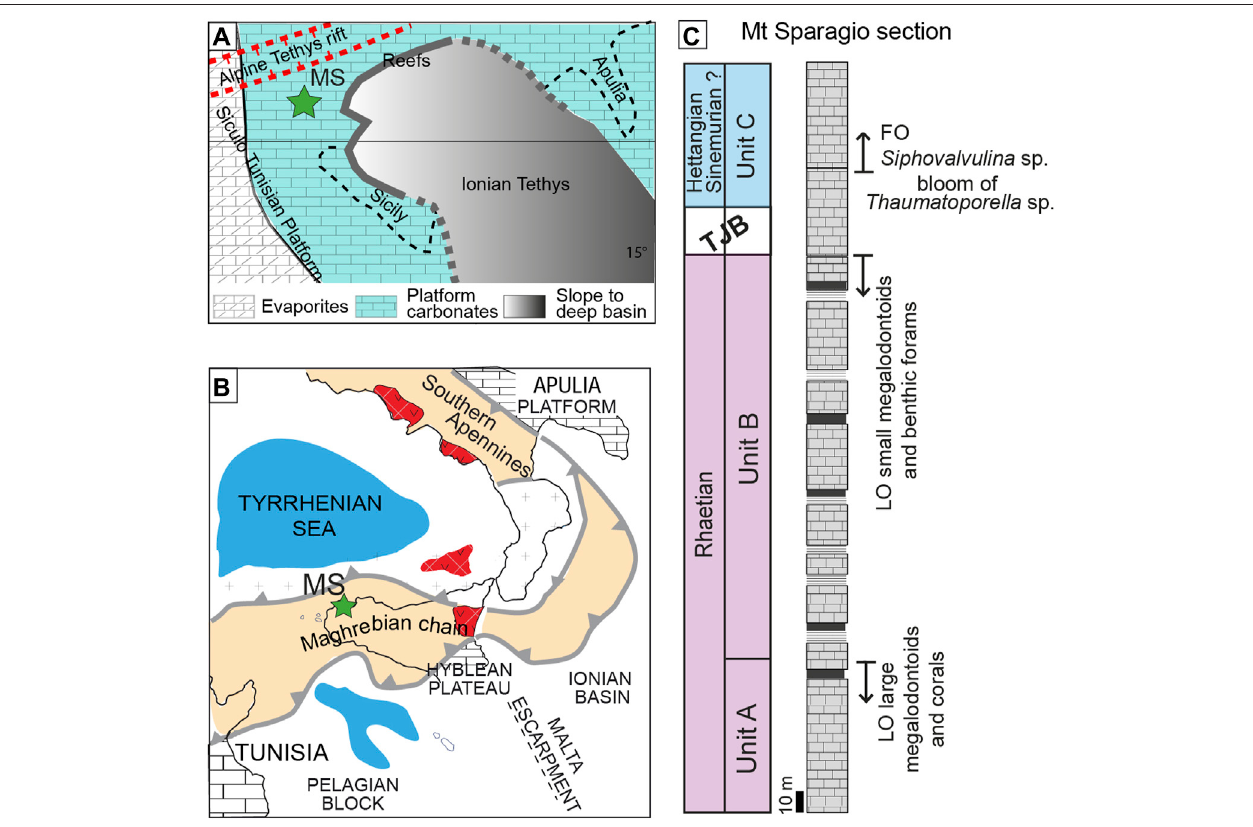
FIGURE 1 | (A) Paleogeography of the central Mediterranean area during the Late Triassic (modi fi ed after Di Stefano et al., 2015; paleolatitude after Muttoni et al., 2015). (B) SchematicstructuralmapoftheCentralMediterraneanarea. (C) ThethreeinformalunitsdescribedintheMtSparagiosectiondifferentiatedonthebasisofthe fossil associations in the subtidal facies (Modi fi ed after Todaro et al., 2018).